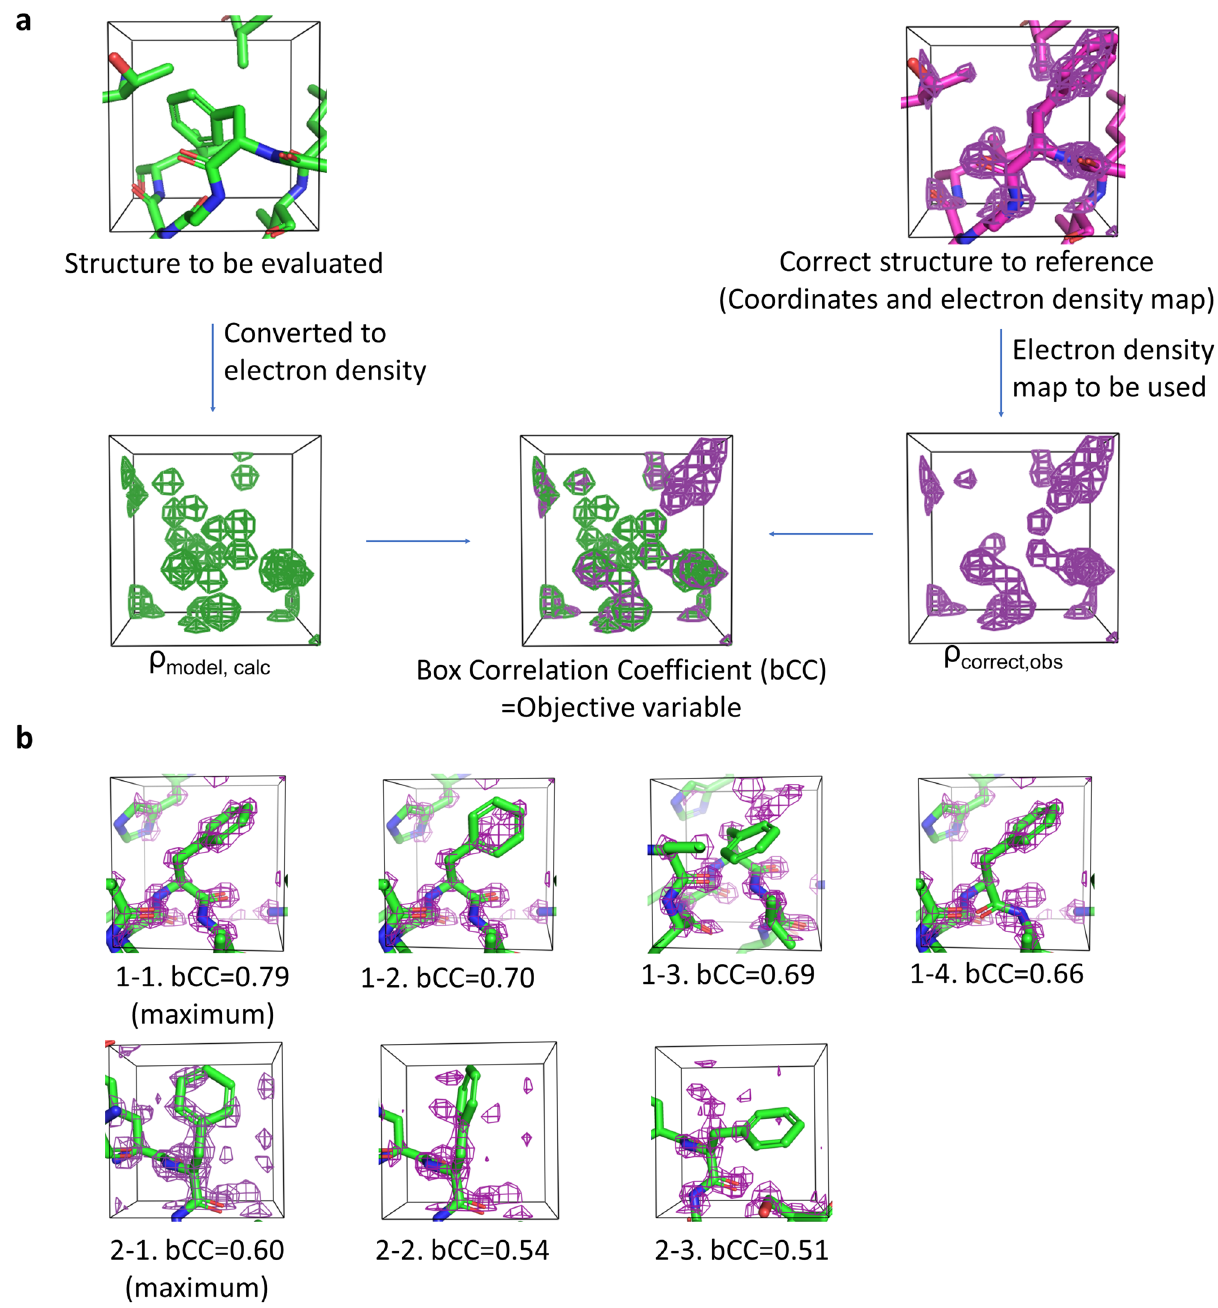
Figure 2. Objective variable. ( a ) Definition of box correlation coefficient (bCC). An example involving a box of size 8.0 Å is shown. The electron density of the correct structure is in magenta, and that calculated from the coordinates to be evaluated is in green. ( b ) Examples of various bCC values, calculated with 1LC0 (resolution, 1.20 Å). Phenylalanine residues were used with maximum bCCs of 0.790 (1-1; Phe256) and 0.595 (2-1; Phe160), the latter was located where the electron density of the correct structure was more blurred than that of the former. The bCC values decreased with fluctuations in the structure (1-2 to 4, and 2-2,